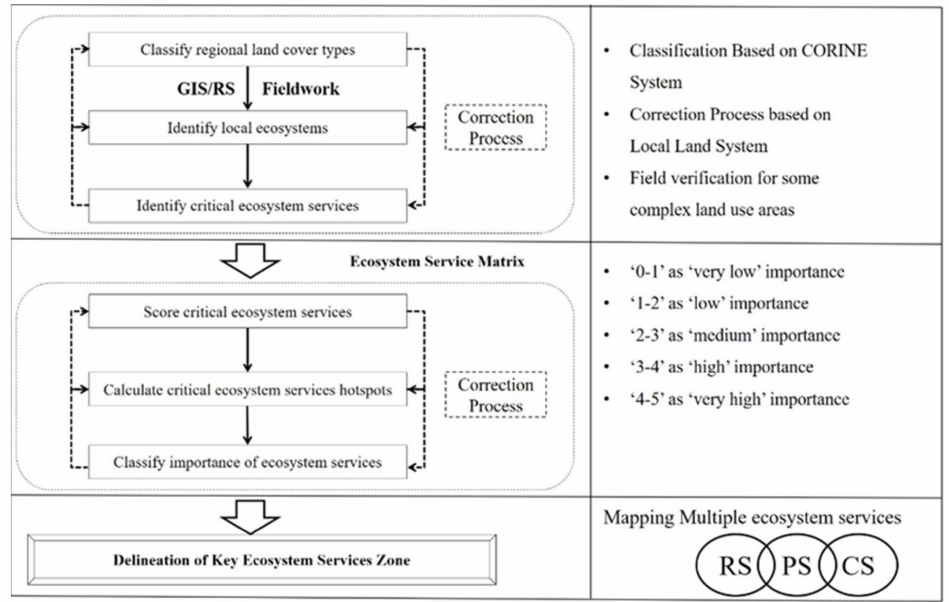
Figure 1. Framework for key ecosystem services (ES) zone